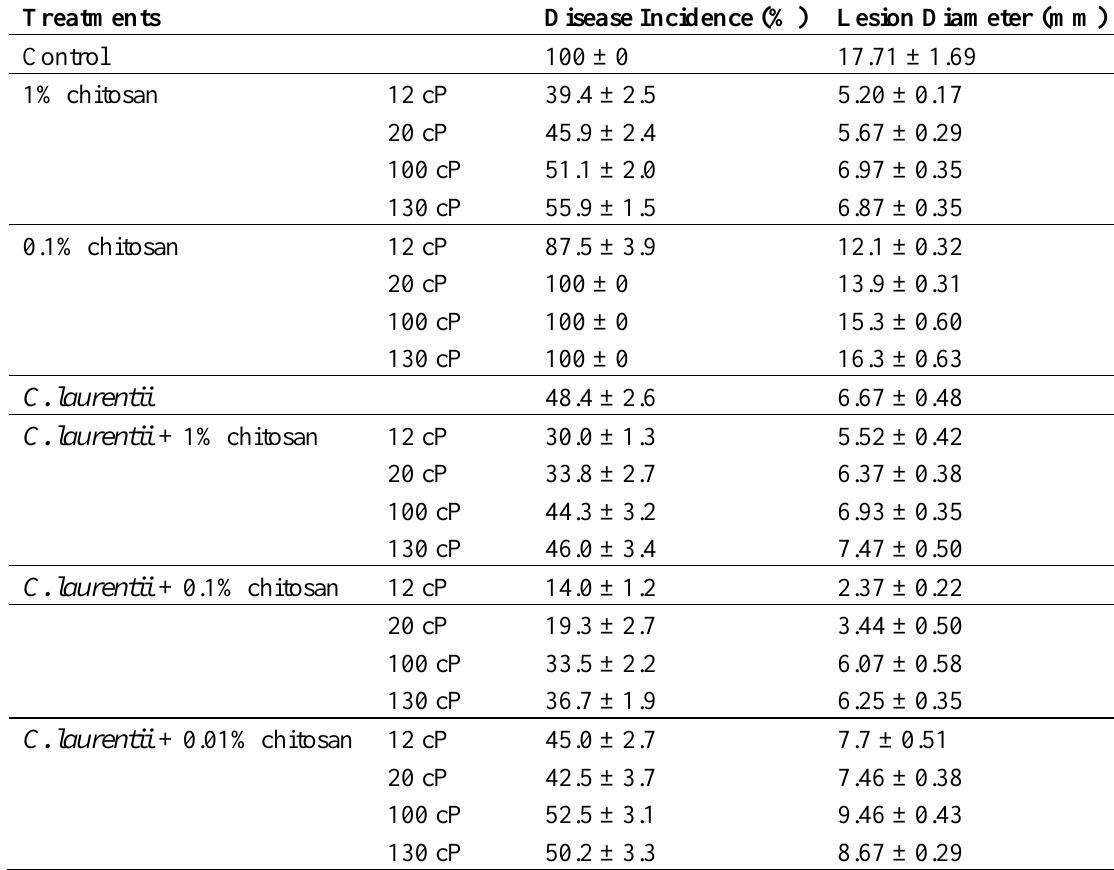
Table 3. Effects of chitosan at different concentrations with various viscosities, alone, or in combination with Cryptococcus laurentii on the reduction of the blue mould rot in apple fruit wounds. Reproduced from Reference [61].